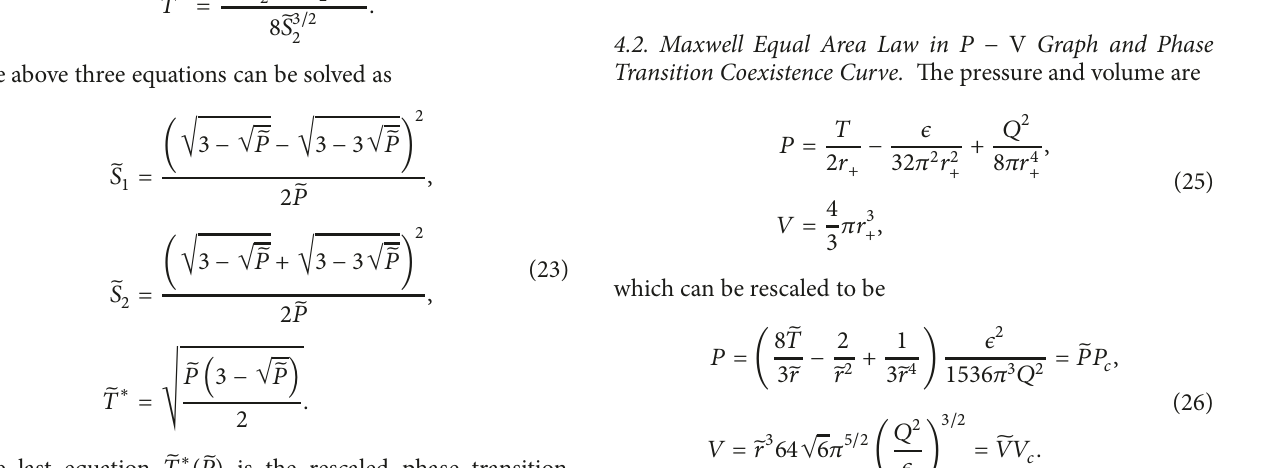
Figure 3 for 𝜖 = 8𝜋 (left) and 𝑄 = 1 (right). The end points in the graphs are the critical points. With fixed 𝜖 and 𝑄 , the phase transition coexistence curve 𝑇(𝑃) is reminiscent of the var der Waals system’s liquid-gas phase transition coexistence